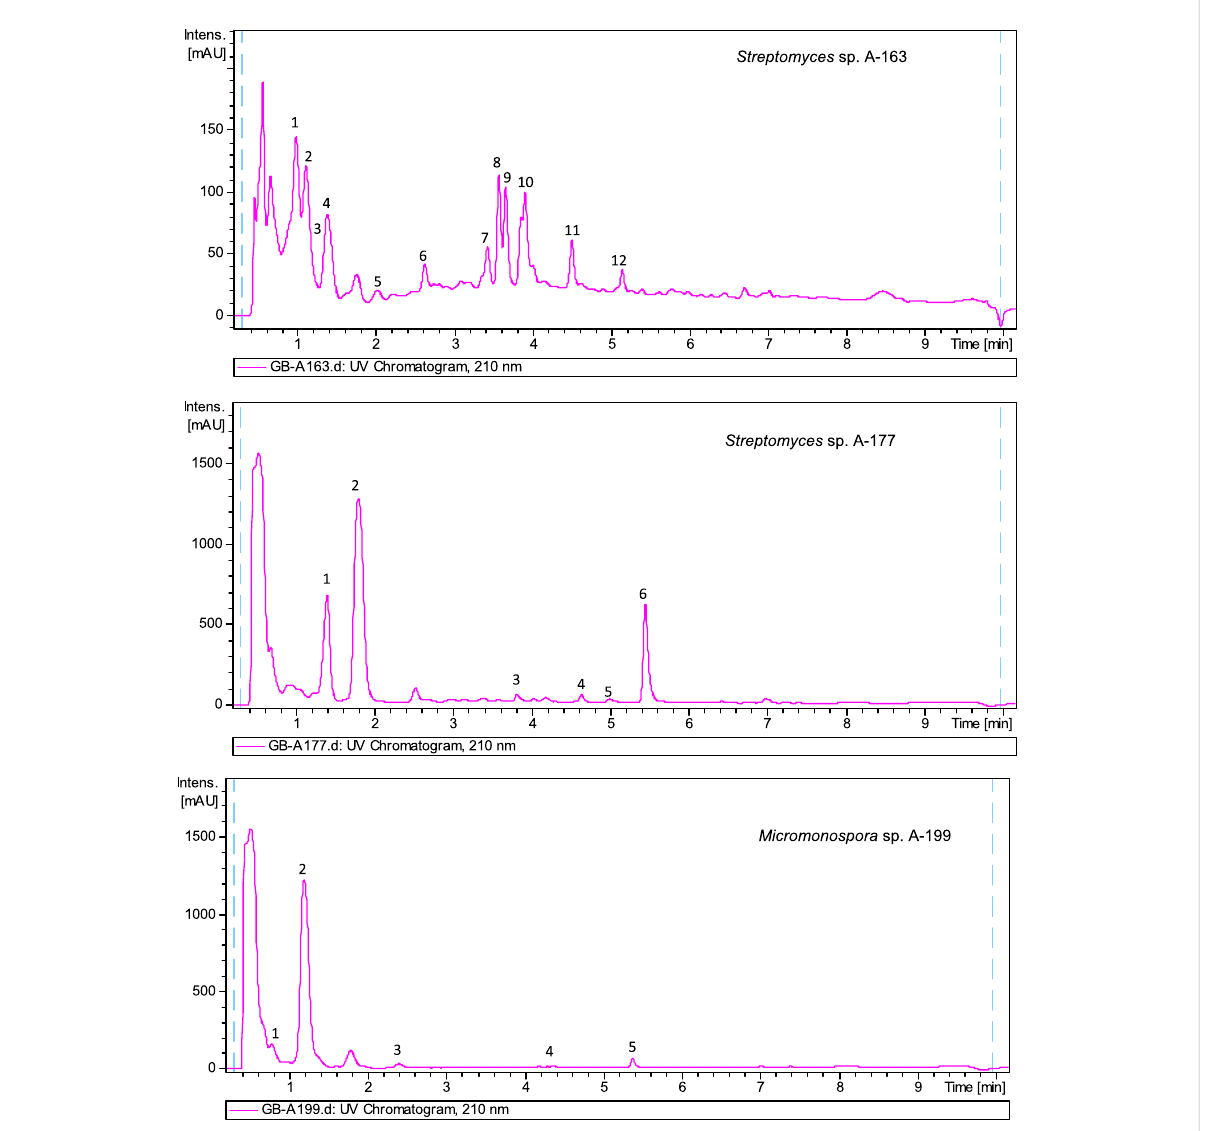
FIGURE 4 UV 210nm chromatogram of ethyl acetate extracts from Streptomyces sp A-163, Streptomyces sp A-177 and Micromonospora sp. A-199. DereplicatedcomponentsinsampleA-163:1)Hydroxystreptazolin,2)Streptazolin,3)Cyclo(leucylprolyl),4)C 12 H 24 O 4 (molecularformulanotfound in the Dictionary of Natural Products for prokaryotes), 5) C 18 H 16 O 4 (no UV coincidence in the Dictionary of Natural Products for prokaryotes), 6) C 11 H 13 NO 2 (no UV coincidence in the Dictionary of Natural Products for prokaryotes), 7) C 12 H 20 O 3 (no UV coincidence in the Dictionary of Natural Products for prokaryotes) (8 and 9)BE14348B (10) BE14348D/E(11)WS9761B (12)Antibiotic